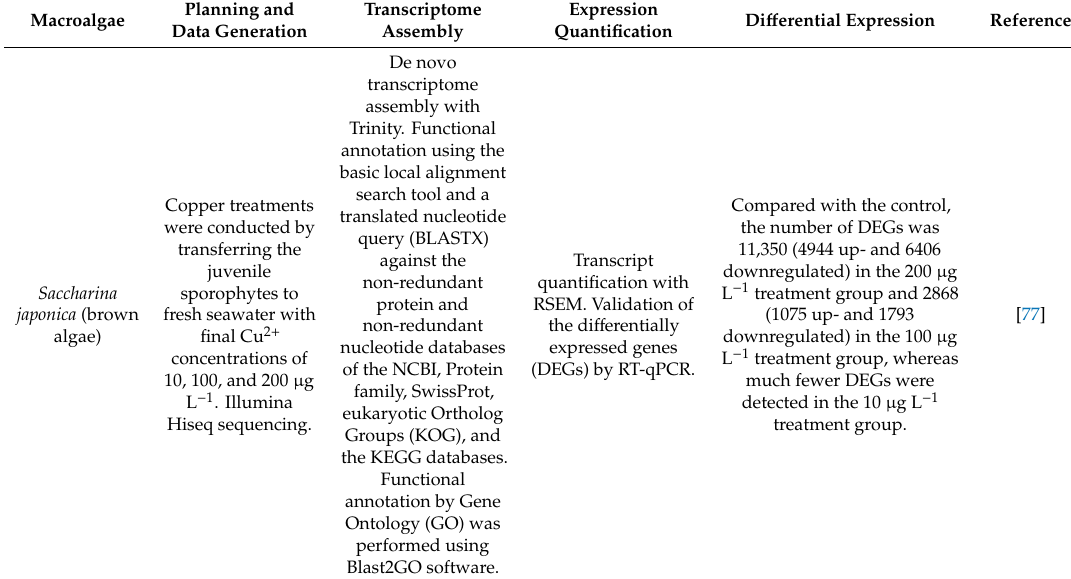
Table 3. Typical transcriptomic approaches according to the investigation of how gene expression in macroalgae can be influenced by abiotic